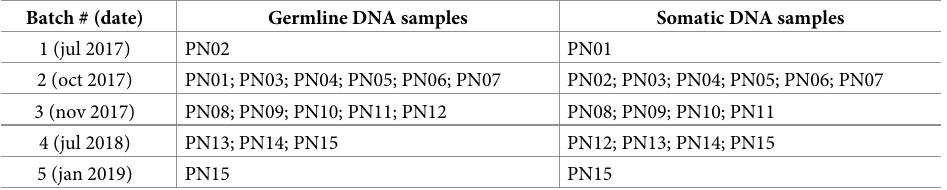
Table 1. Batch information of PitNET exome